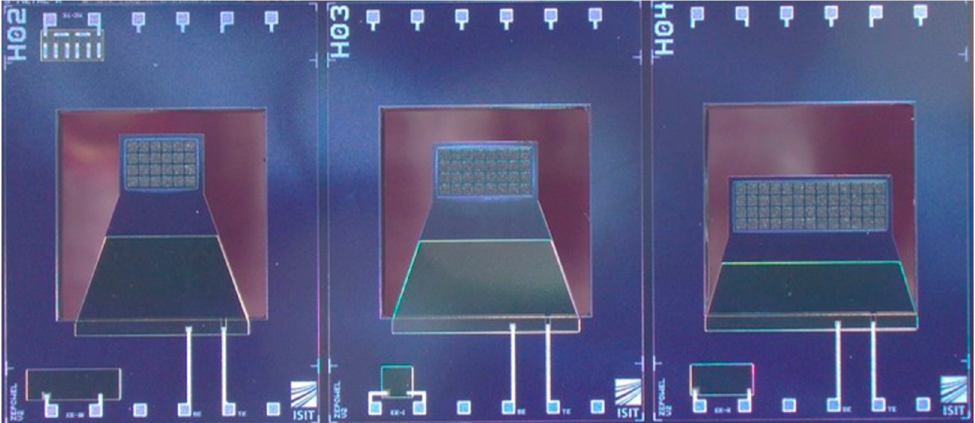
Figure 7. Photograph of different energy harvester dies before dicing. The three different designs were used for comparison in this study.